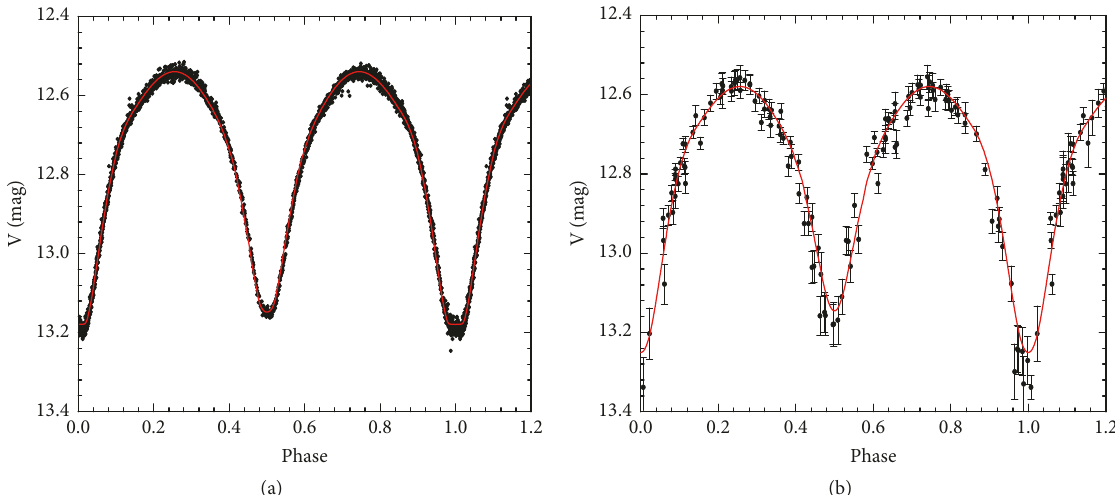
Figure 5: AAVSO’s (a) and ASAS’ (b) light curves. The solid lines are the theoretical LCs, which are computed by the photometric solutions.